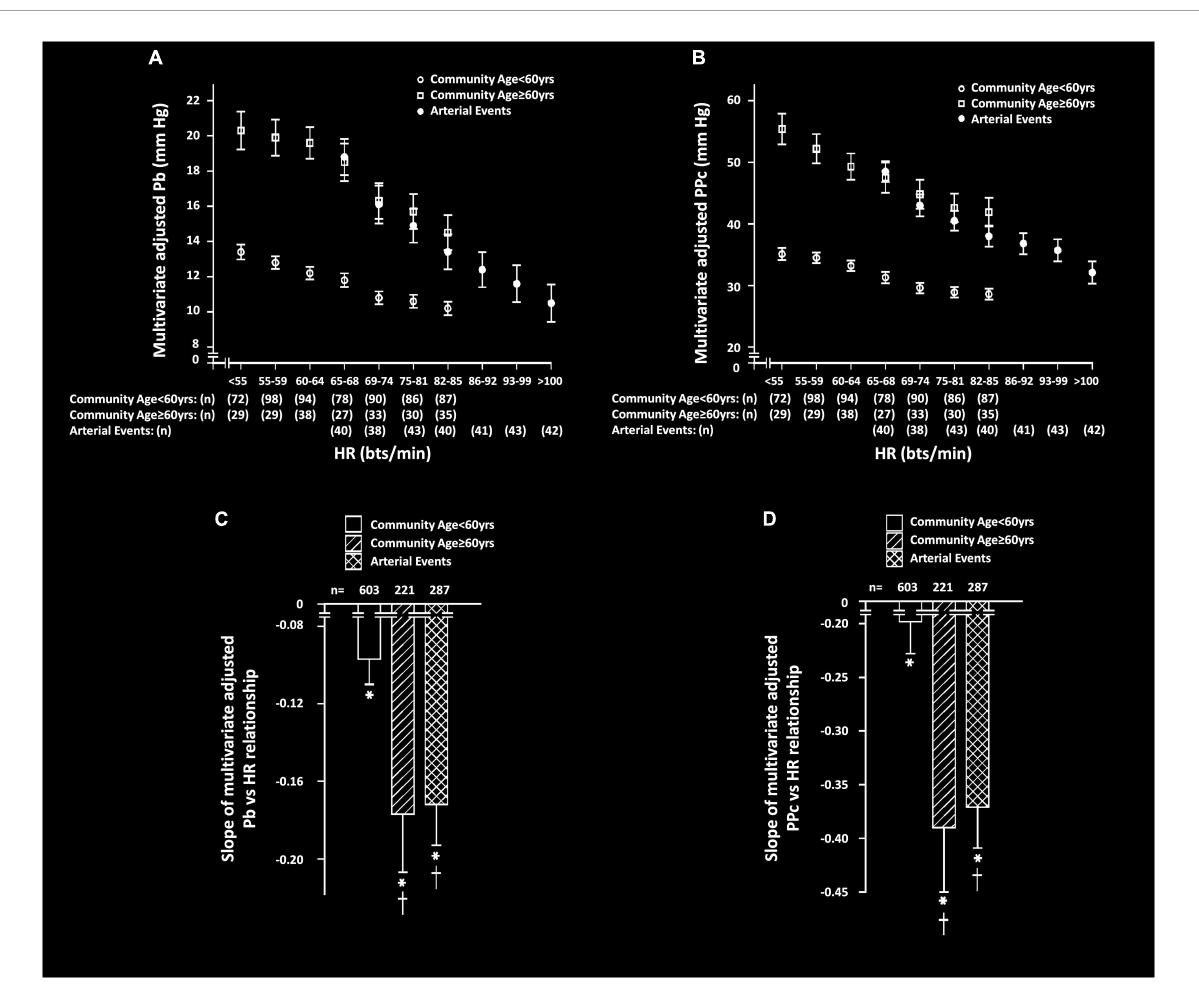
FIGURE1 Multivariate adjusted backward wave pressures (Pb) or central arterial pulse pressure (PPc) across septiles of heart rate (HR) (A,B) and slopes of HR-Pb relationships (C,D) in participants from a community sample either younger (community < 60 years) or older (community ≥ 60 years) than 60 years or in those with arterial events (stroke or critical limb ischemia). Panels C and D show comparison of the multivariate adjusted slope ( β -coefficient) of the relationships. All data are adjusted for age, sex, MAP, BMI, regular smoking, regular alcohol, DM, and antihypertensive therapy. ∗ p < 0.0001 for relationships. † p < 0.01 vs. slopes of relationships in community participants < 60